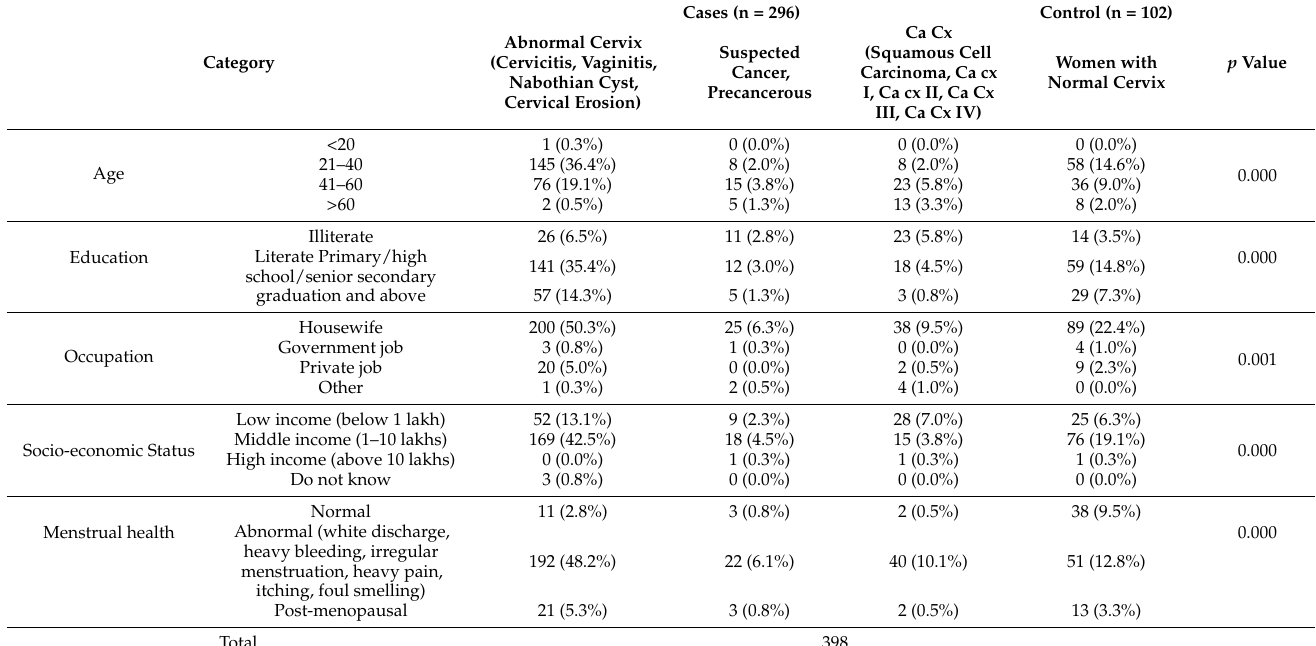
Table 1. Socio-demographic features of these subjects evaluated at the OPD at BHMRC and DSCI (East): it depicts the socio-demographic features of the subjects/patients evaluated at the OPD of BHMRC, New Delhi, India and DSCI (East), New Delhi, India. The socio-economic demo- graphic/epidemiological data (Table 1) of 398 subjects, was labeled by an expert gynecologist as normal, cervicitis, precancerous, suspected cancerous, abnormal (vaginitis, Nabothian cyst, polyp, and cervical erosion), and different confirmed carcinoma in the cervix, which were undertaken to develop the novel OM—The OncoMeter scale to rank the lesions in the order of their severity. Out of 398 subjects, 102 subjects were found to be normal; 57 had cervicitis; 167 subjects were found to have abnormal lesions; 3 were precancerous; 25 were suspected of cancer and squamous cell carcinoma each; and 5, 9, 3, and 2 had ca cx I, ca cx II, ca cx III, and ca cx IV, respectively. It was observed